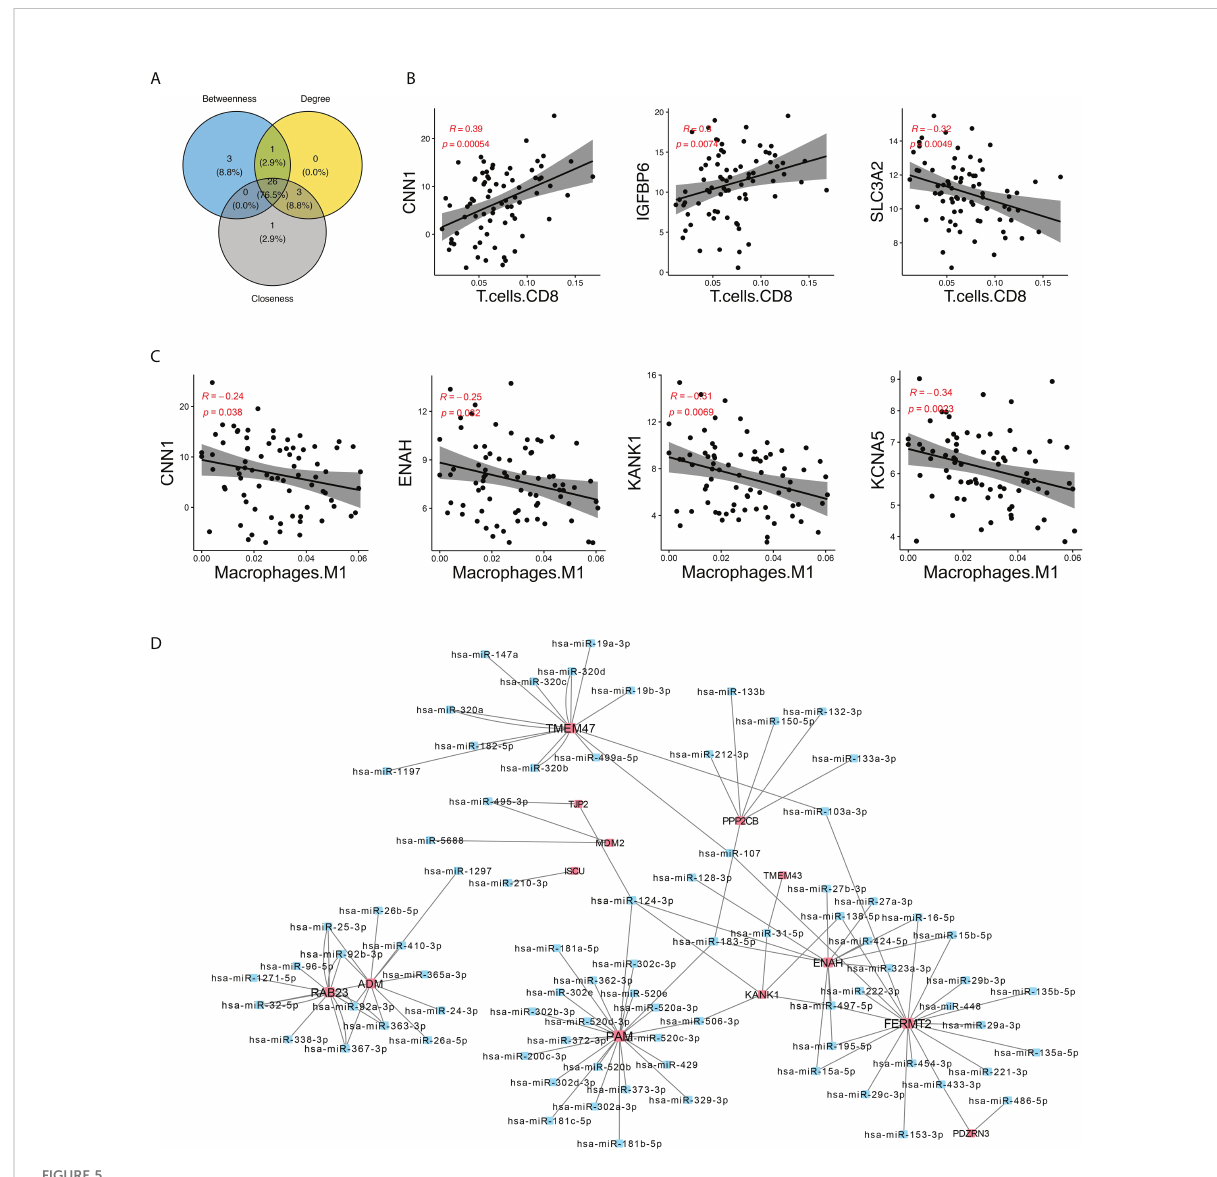
FIGURE 5 Identi fi cation of hub genes in the network. (A) Venn plot showing the intersection of genes identi fi ed by three algorithms. (B, C) Spearman ’ s correlation between hub DEGs CNN1, IGFBP6, and SLC3A2 and CD8 + T cells and M1 macrophages. (D) miRNA – genes network. The interactions between miRNA and target genes were predicted by seven bioinformatics tools; interactions appeared in at least fi ve tools were visualized here. Genes are colored in red, while miRNA are colored in